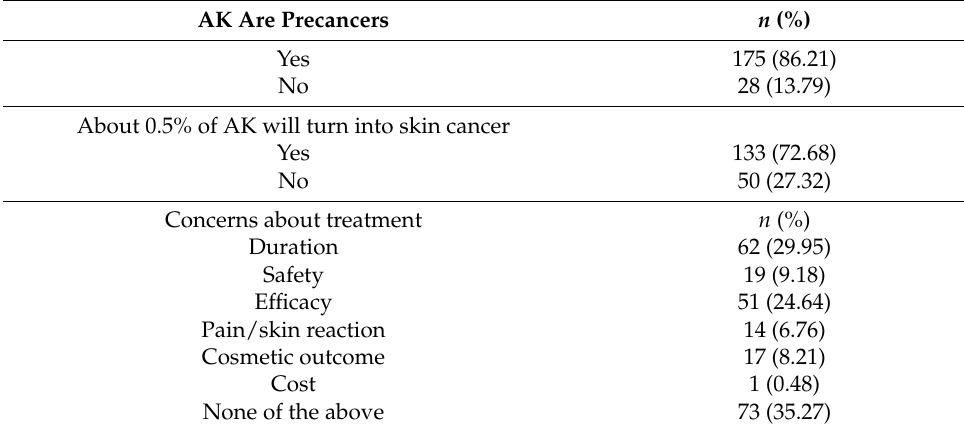
Table 4. Treatment perception questions, Questionnaire Part